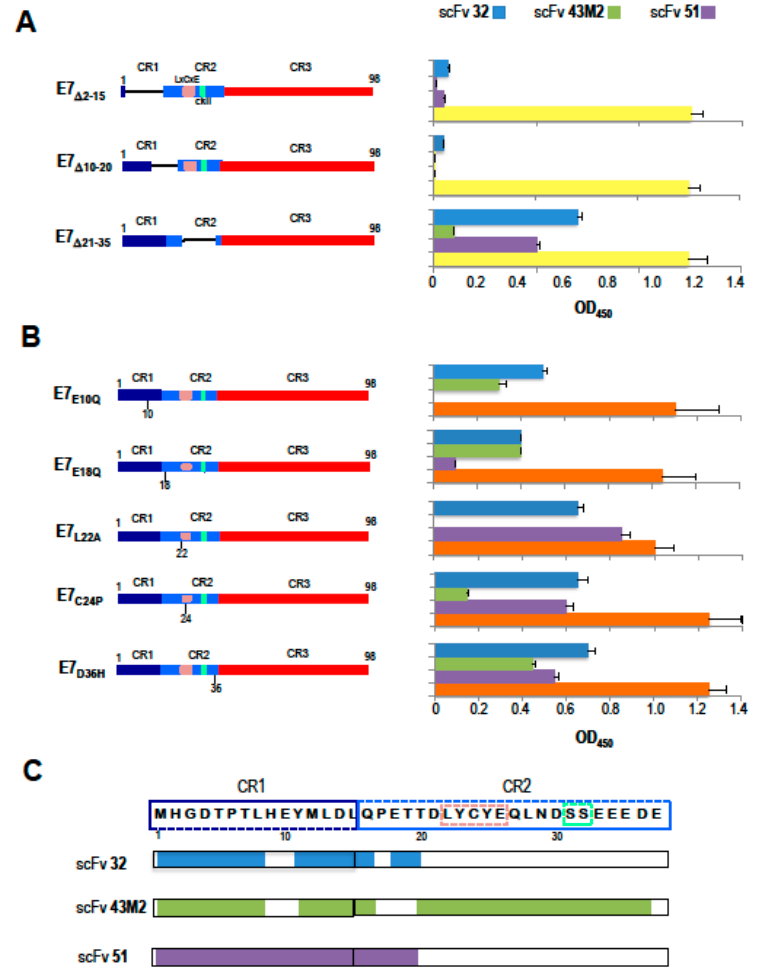
Figure 2. Epitope mapping of anti-E7 scFvs binding site on the 16E7 oncoprotein. ( A ) Schematic representation of 16E7 deletion mutants with the deleted amino acids, indicated by ∆ , is shown on the left. The conserved CR1, CR2 and CR3 regions, the conserved LxCxE motif responsible for pRb binding and the casein kinase II (CKII) phosphorylation site in the CR2, are also indicated. The bars on the right represent the reactivity in ELISA, of scFv32 (light blue), scFv43M2 (green), scFv51 (violet) and in-house-made anti-E7 mouse polyclonal antibody (yellow), against each mutant. Data are expressed as the mean ± SD of three independent experiments, each performed in triplicate. ( B ) Schematic representation of the 16E7 mutants carrying single aa variations is shown on the left. E7 E10Q has a variation from glutamic acid (E) to glutamine (Q) at position 10, and the same change is present in E7 EQ18 at position 18, while E7 L22A has a variation from leucine (L) to alanine (A) at position 22. E7 C24P has proline (P) instead of cysteine (C) at position 24, while E7 D36H has histidine (H) instead of aspartic acid (D) at position 36. The results of the ELISA performed with the same mutants are shown on the right. The color code for scFvs is the same as in panel A. The reactivity of the anti-E7 mAb is indicated in orange. Values are the mean ± SD of four independent experiments, each performed in triplicate. ( C ) The aa sequence of the E7 N-terminal region. CR1 and CR2 sequences, as well as the pRb binding and the CKII-phosphorylation sites in the CR2, are delineated by dashed line boxes with color codes, as in panels A and B. The E7 regions, bound by the scFvs indicated on the left, are highlighted by the respective color